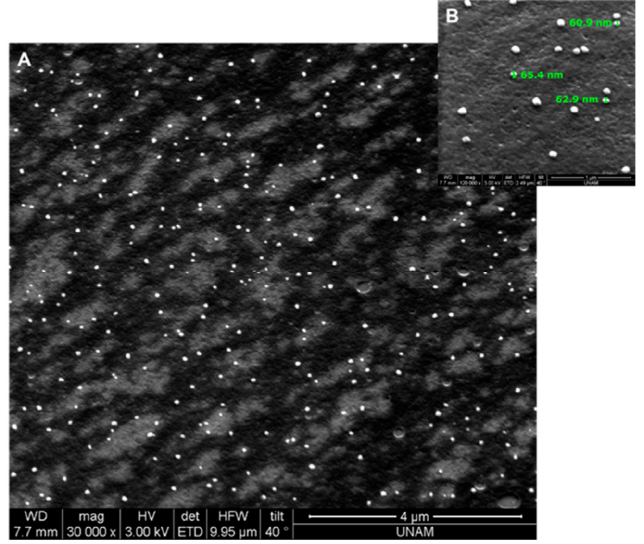
Figure 25. The scanning electron micrographs of PVP nanogels at two different magnifications ( A , B ). Reproduced from [291]. License obtained from Elsevier.